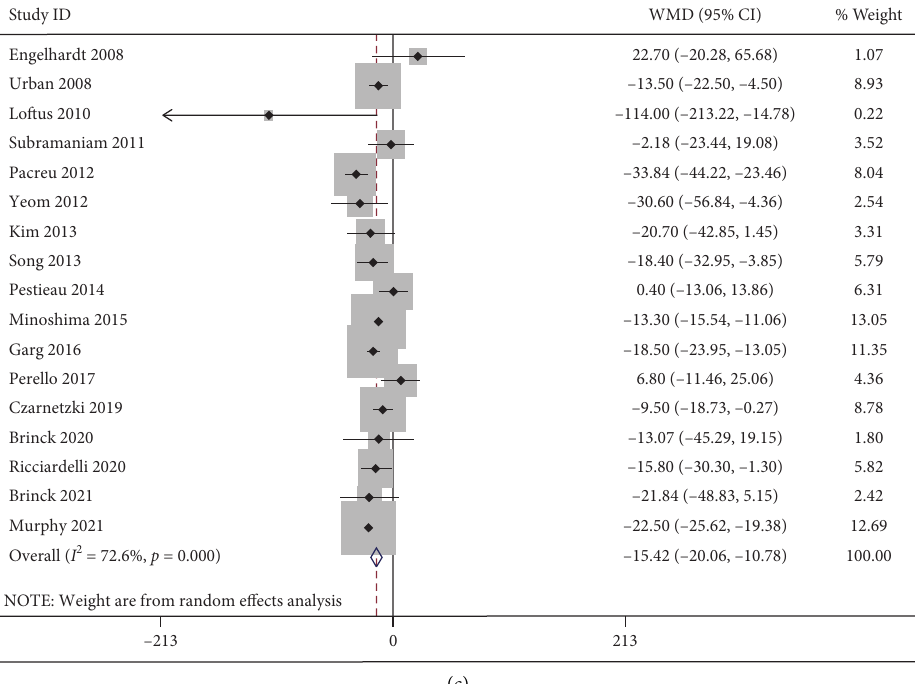
Figure 5: Forest plot of the cumulative opioid consumption for the ketamine group and control group. (a) First 12h; (b) first 24h; (c) first